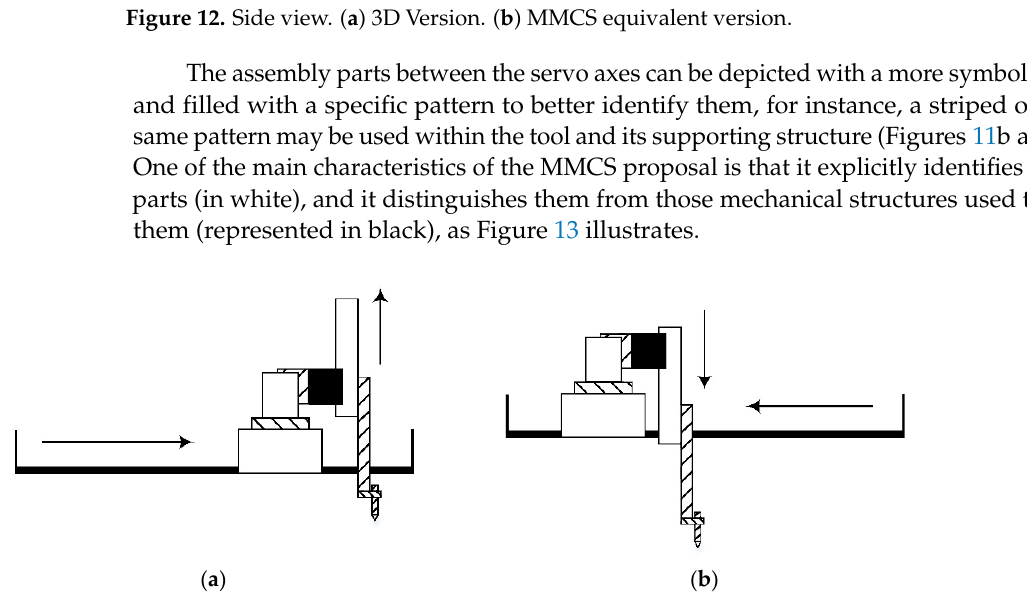
Figure 13. Cartesian system movement. ( a ) Movement up and to the left; ( b ) movement down and to the right.